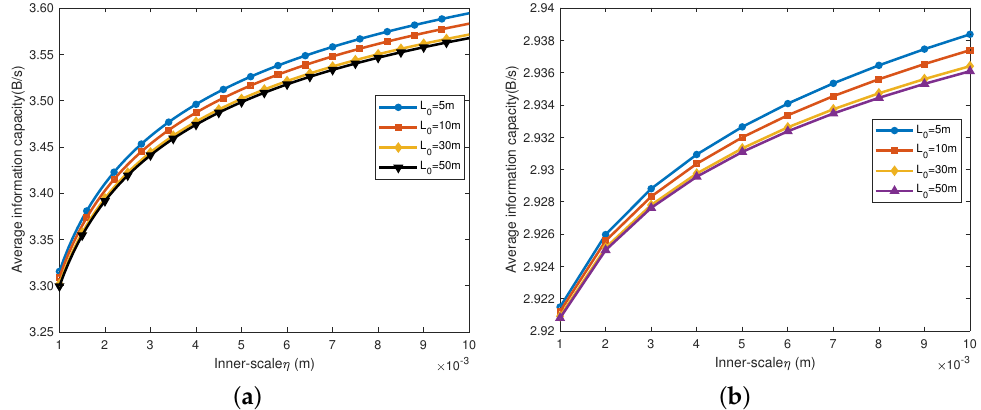
Figure 11. The capacity of the POV carrier link versus the inner scale for different outer scale under ( a ) 4-QAM, z = 100 m, and ( b ) 256-QAM, z = 150